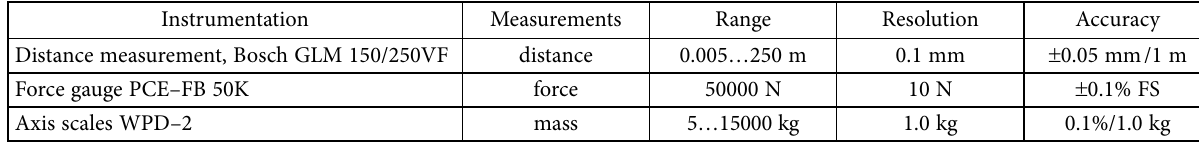
Table 2. Specifications of measurement